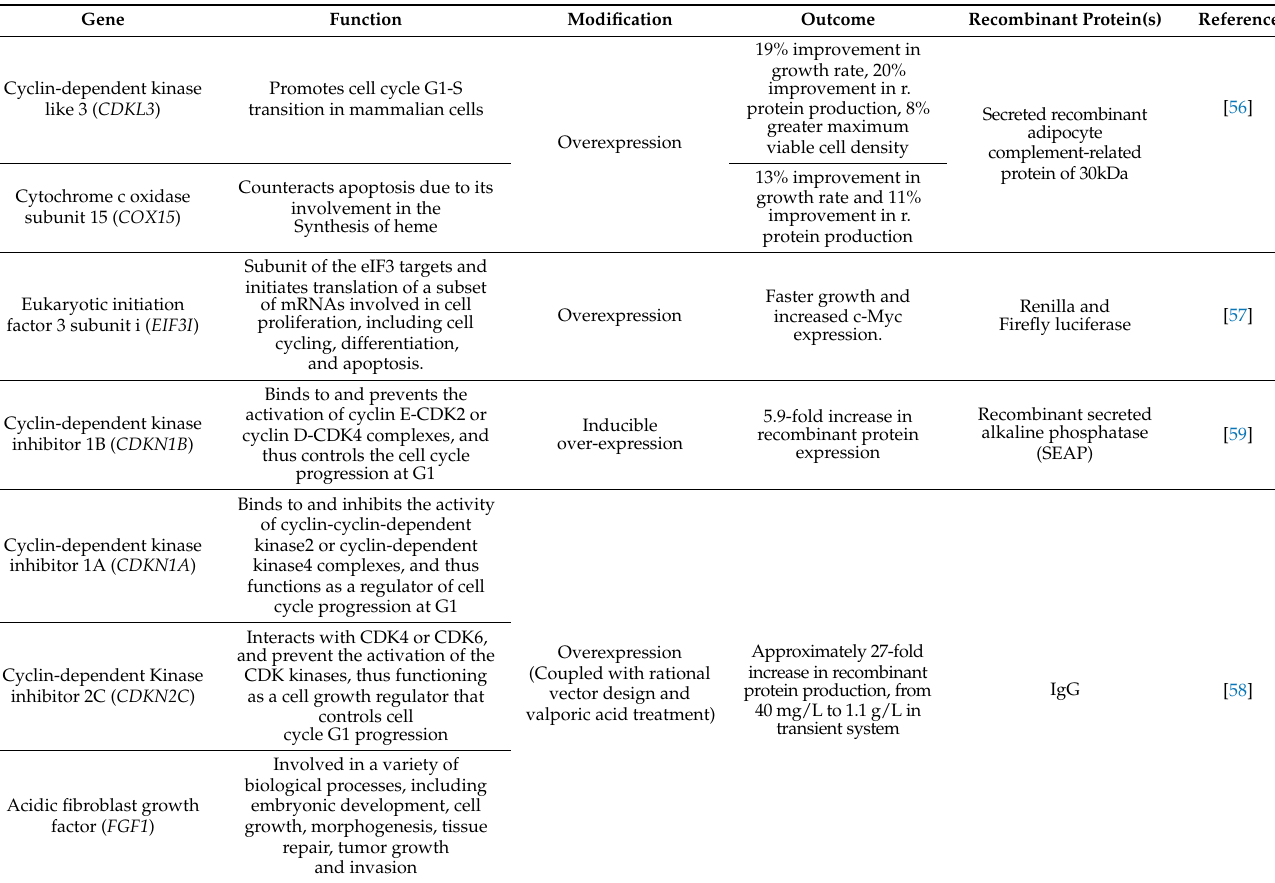
Table 2. Genes that have been engineered to modulate proliferation in the HEK293 cell